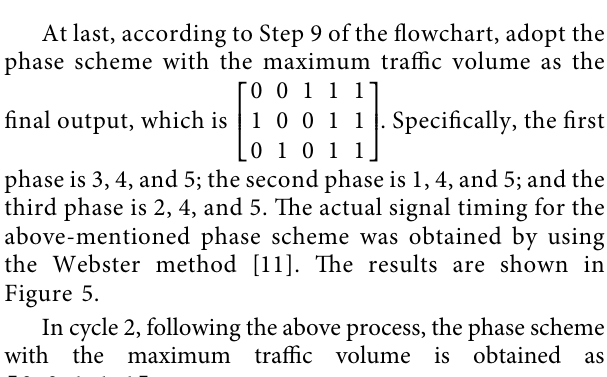
Tree common intersection evaluation indicators including average queue length, average number of stops, and average delay are adopted for performance comparison. After the